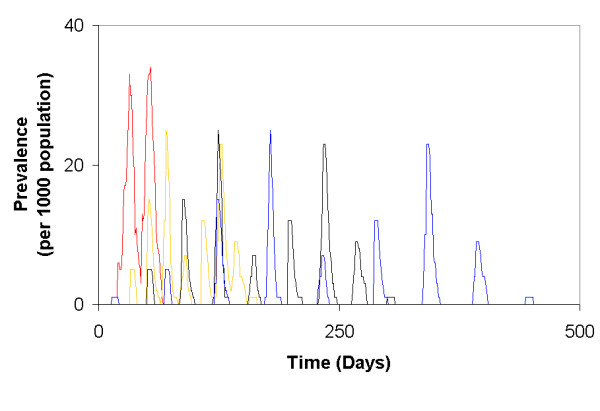
Prevalence of a disease (per 1000 population) based on different values of ωi. Here, ωi = 1.0 × 10-1 (red curve), 1.0 × 10-3 (yellow curves), 1.0 × 10-6 (black curves), and 1.0 × 10-9 (blue curves).